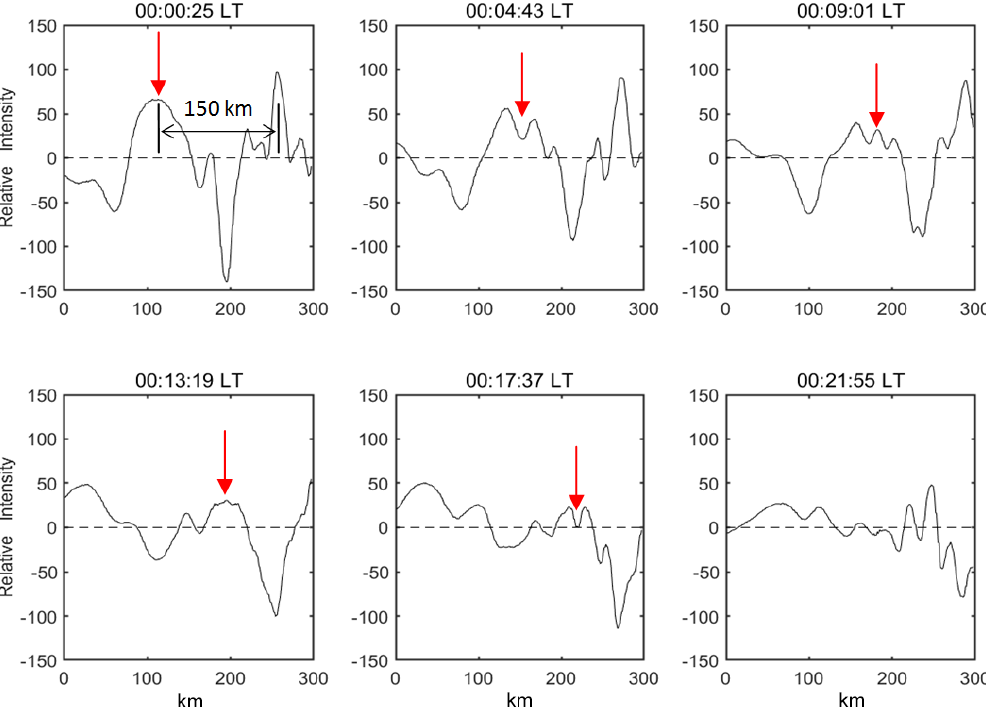
Figure 11. Time series of the averaged OH image slices perpendicular to the wavefronts as marked by four yellow dotted lines ( a , b , c , and d ) in Fig. 10. The wavefronts propagate from left to right. The red arrows mark the evolution of the wavefront peak.